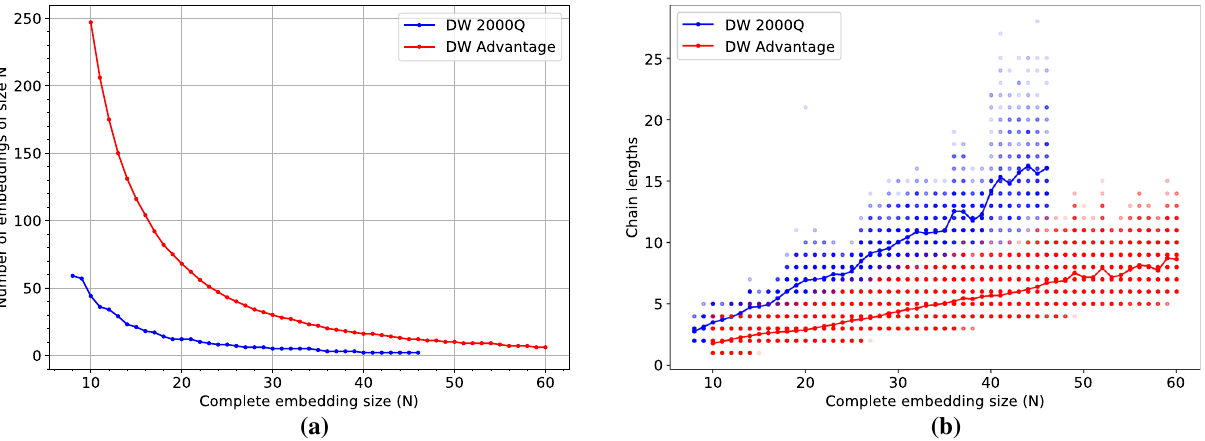
Figure 8. ( a ) Number of embeddings as a function of the embedding size (clique size) N for DW 2000Q (blue) and DW Advantage (red). ( b ) Scatter plot of the chain lengths occurring in the embeddings as a function of the embedding size N , with the average depicted as a line. For DW 2000Q, we consider cliques of sizes N ∈ { 8, . . . , 46 } , while N ∈ { 10, . . . , 60 } for DW